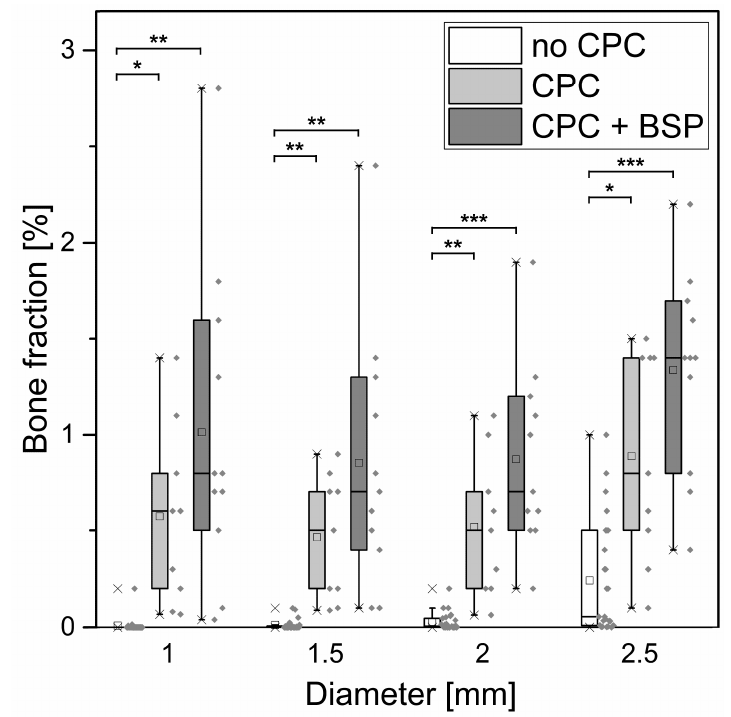
Figure 6. Boxplot of the bone fraction (bone volume (BV)/total volume (TV) ratio) after eight weeks. The core of the scaffold is represented by a virtual cylinder with a diameter of 1.0 mm, whereas the total scaffold is represented by a diameter of 2.5 mm. Therefore, different diameters illustrate bone ingrowth into the different layers of the scaffold. Statistically significant differences are labeled by asterisks (*: p < 0.05, **: p < 0.01, ***: p < 0.001).